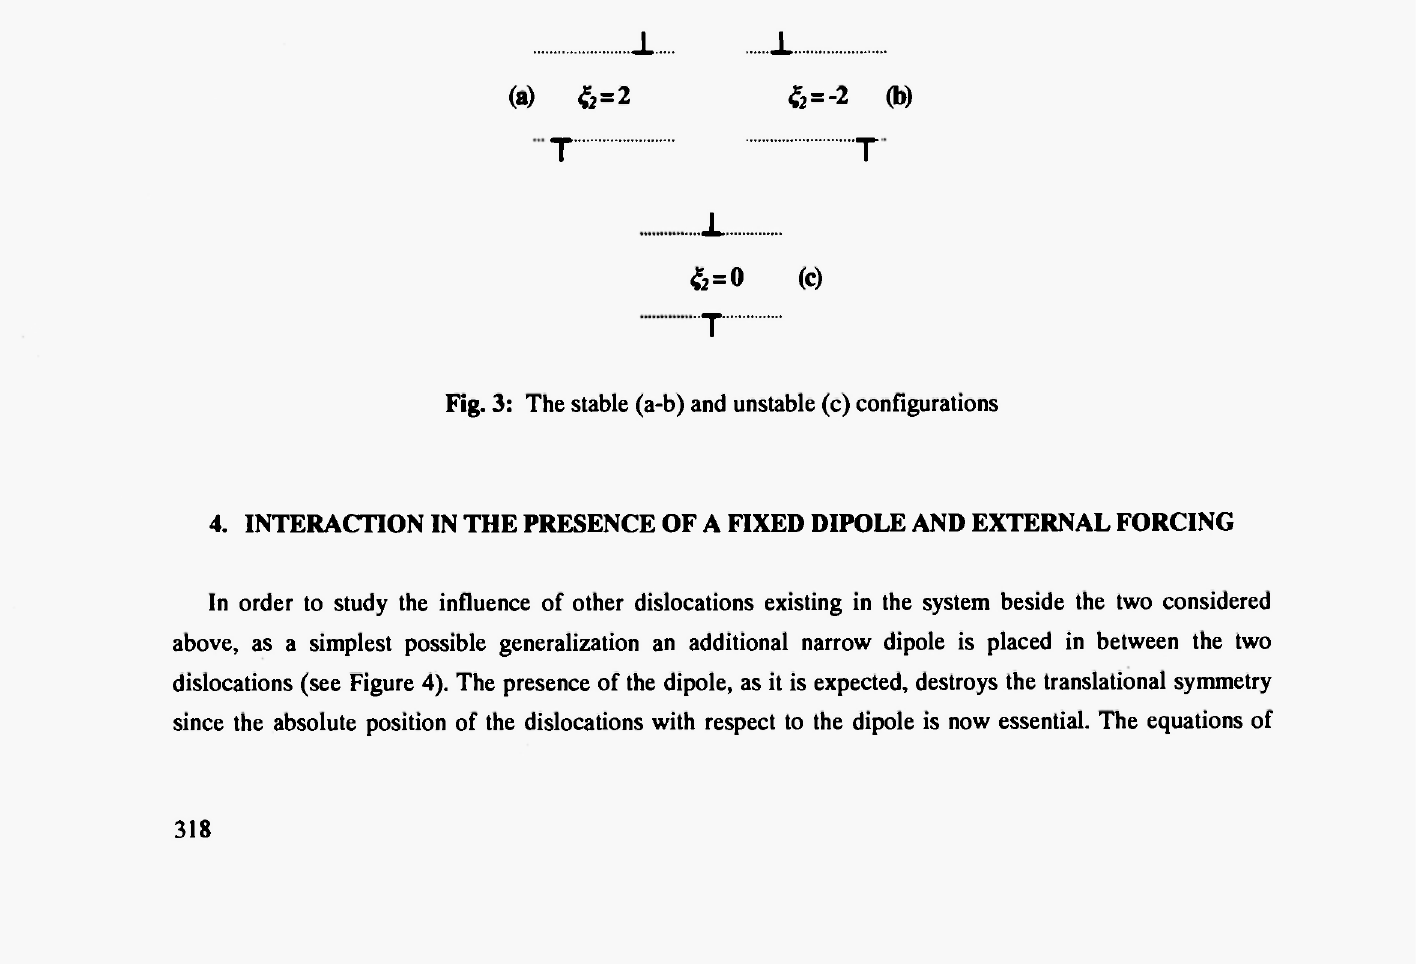
Fig. 3: The stable (a-b) and unstable (c)